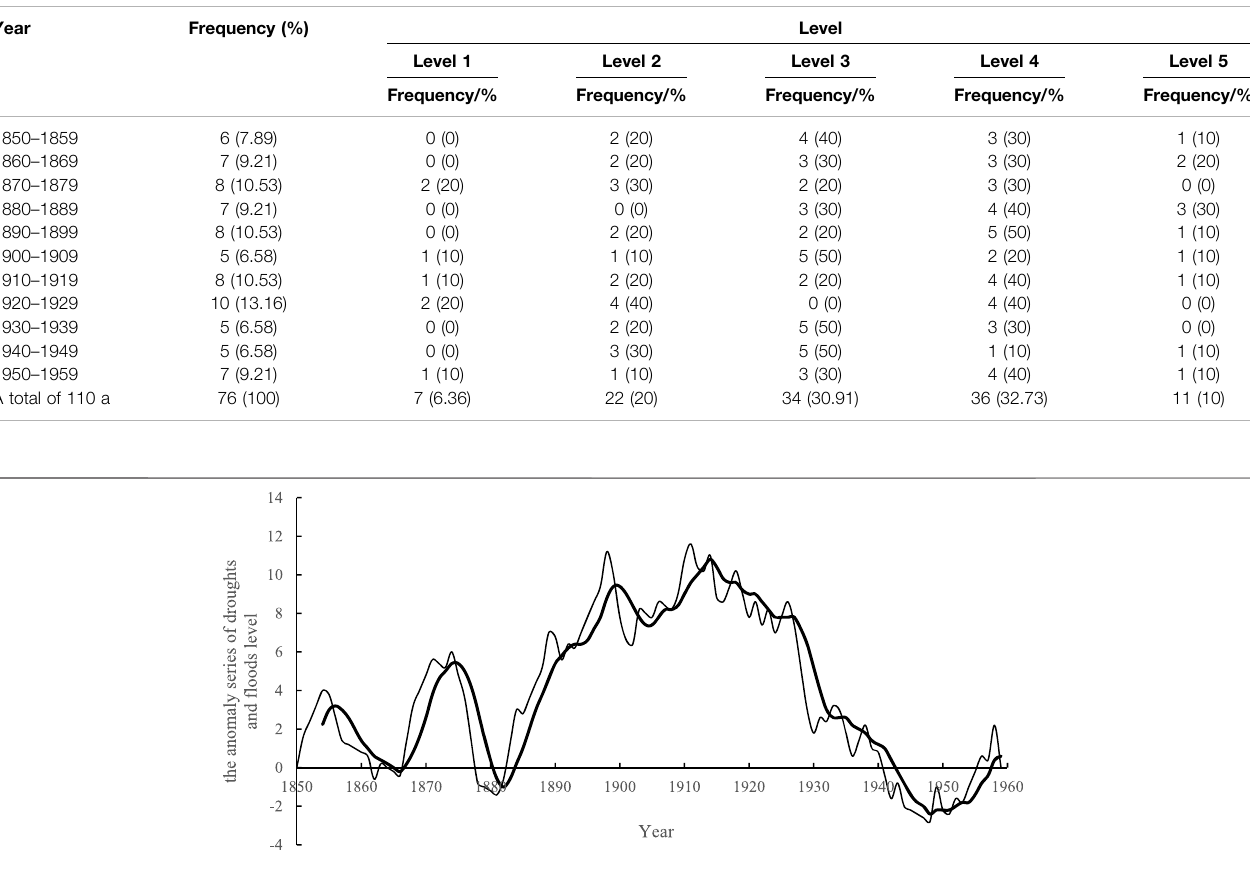
FIGURE3| Theanomalyseriesofdroughtand fl oodlevelsintheQinlingMountainsfrom1850to1959(thethinlineistheanomalyseriesofdroughtand fl oodlevels, and the thick line is the movable sequence for 5 years)